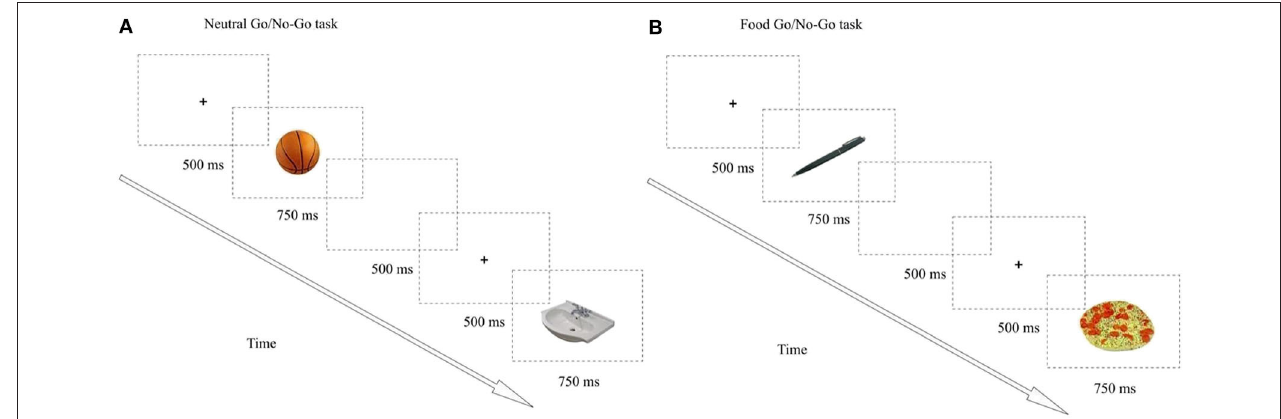
FIGURE 2 | The Go/No-go paradigm. (A) Neutral task, (B) Food task. Each task had 100 trials divided in two blocks of 50. A total of 200 trials were presented (Neutral + Food). Images were presented using a ratio of 80% “go” to 20% “no-go” trials to create a prepotent “go” response. Each trial was presented for 750 ms and was separated by a blank screen for 500 ms and preceded by a fixation point for 500 ms. The go and no-go categories were presented in a pseudorandomized order, with 3, 4 or 5 go trials in between every no-go trials. Presentation order of the food and neutral tasks was fully